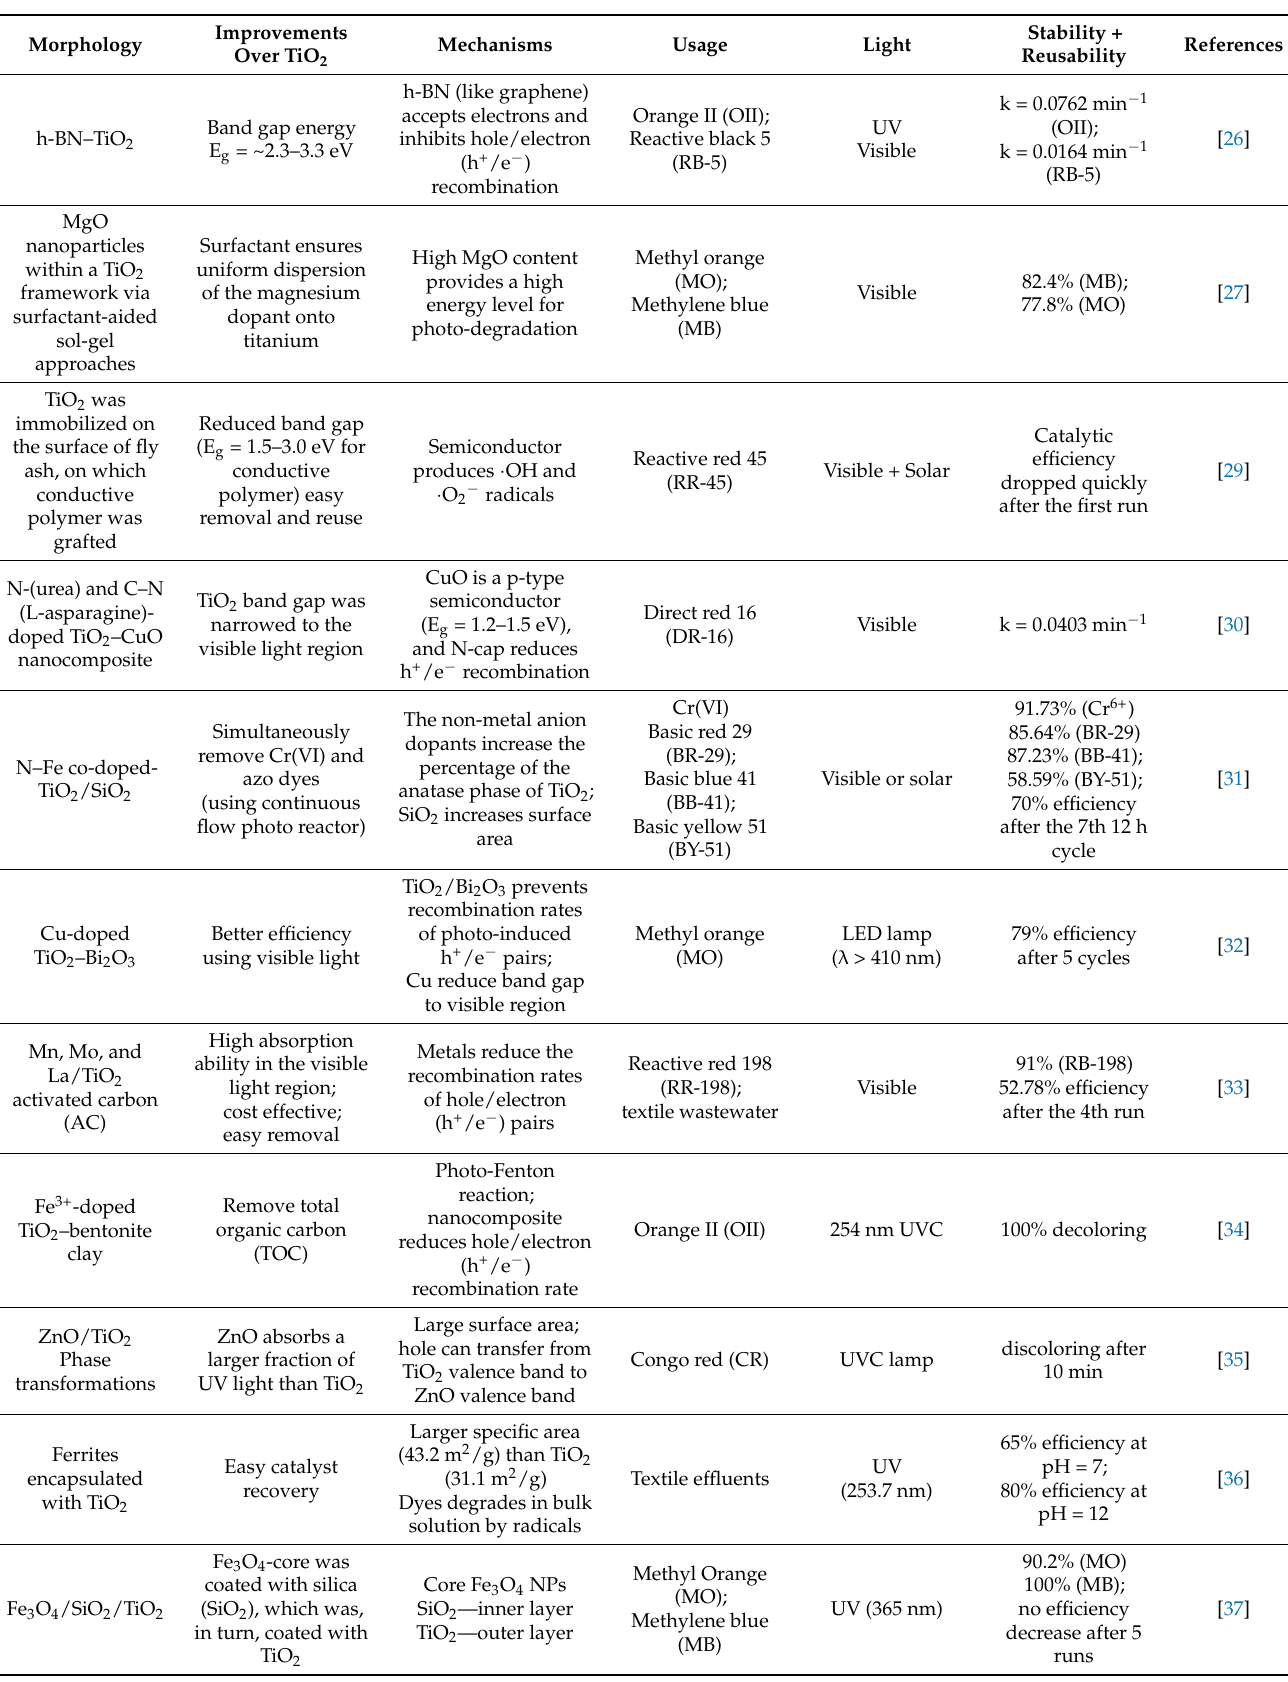
Table 2. TiO 2 -based nanocomposites for photo-degradation of azo